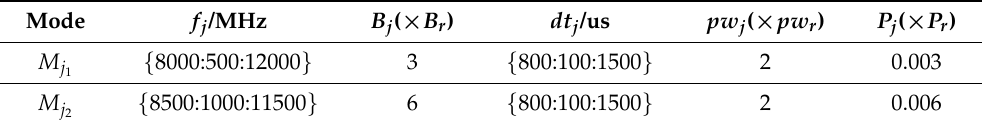
Table 2. Jamming parameter template. When a jamming mode is determined, the corresponding pulse parameters are selected according to the rules in the template. { A:B:C } denotes a set of optional values, consisting of an arithmetic sequence from A to C with B as the